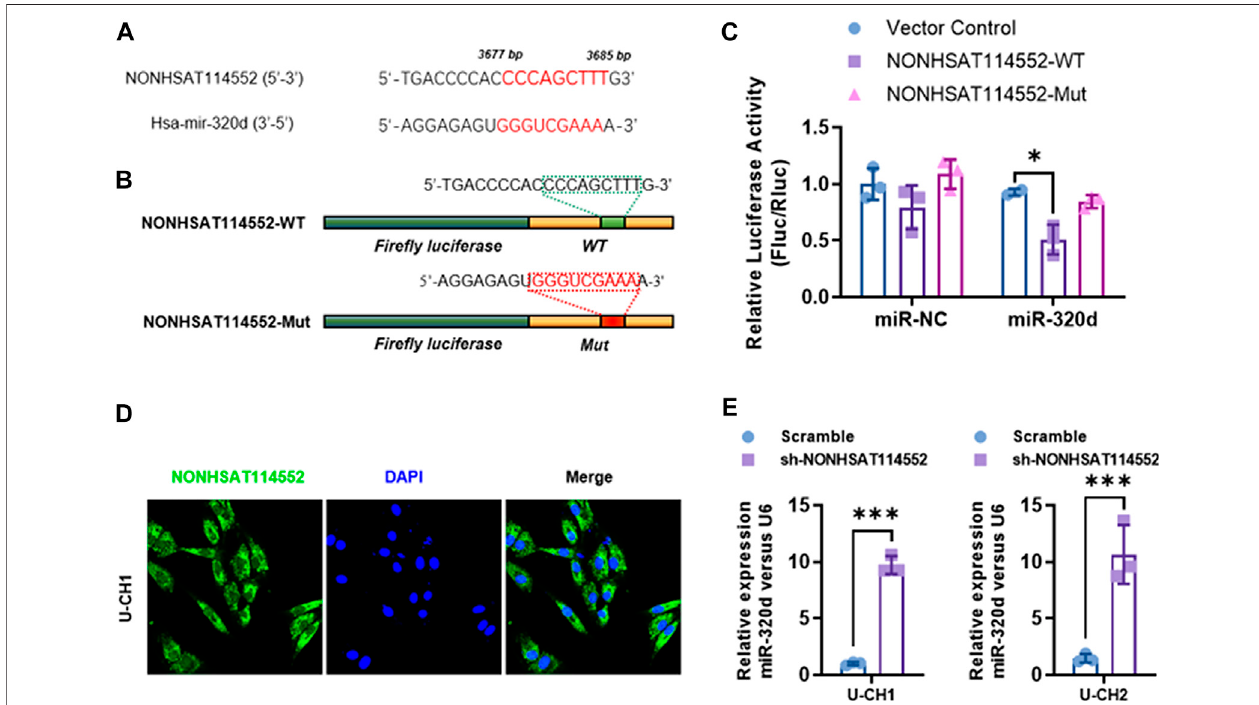
FIGURE 3 | NONHSAT114552 directly targets miR-320d in chordoma (A, B) . Bioinformatic analysis identi fi ed miR-320d binding sites in the 3 ′ UTR of NONHSAT114552and luciferase reporter plasmid including NONHSAT114552-WT or NONHSAT114552-Mut wassubsequently shown (C) . On the basis ofluciferase reporter assay, miR-320d signi fi cantly decreased luciferase signals of NONHSAT114552-WT reporters, but did not affect NONHSAT114552-Mut reporters (D) . FISH assay showed location of NONHSAT114552 in U-CH1 cells (E) . miR-320d relative expression level was signi fi cantly up-regulated after knockdown of